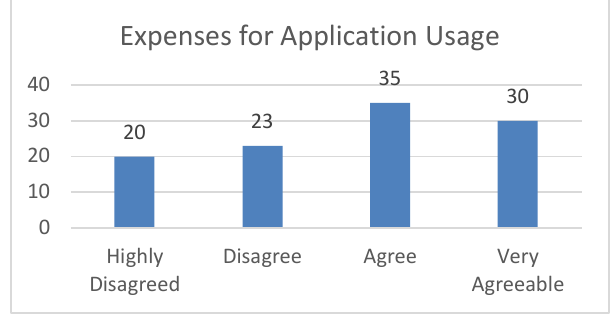
Figure 3: Costs for Application Usage; Source: Own elaboration.